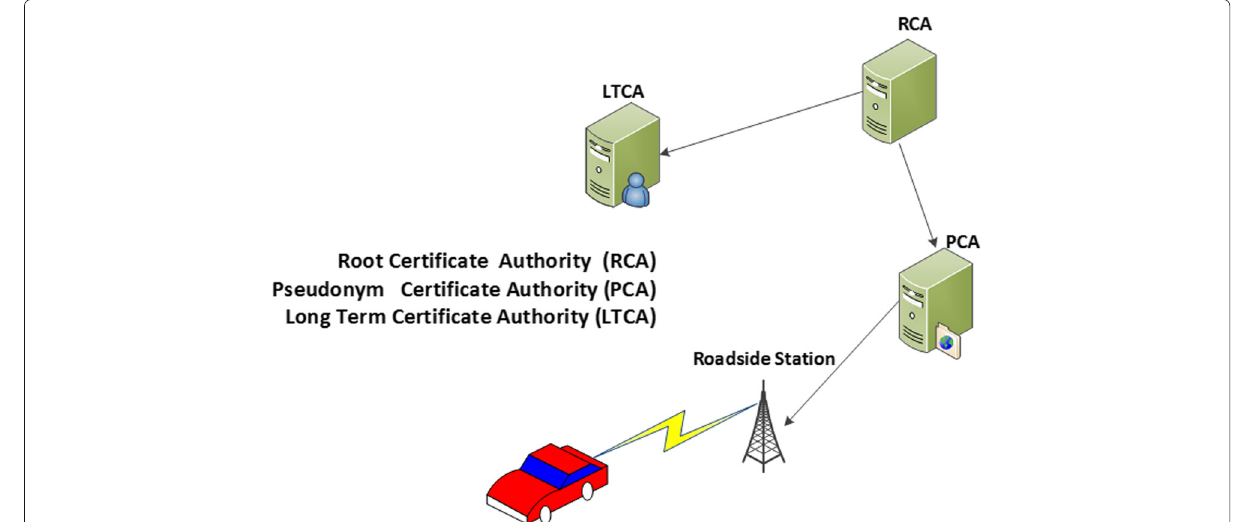
Fig. 2 Simple VPKI